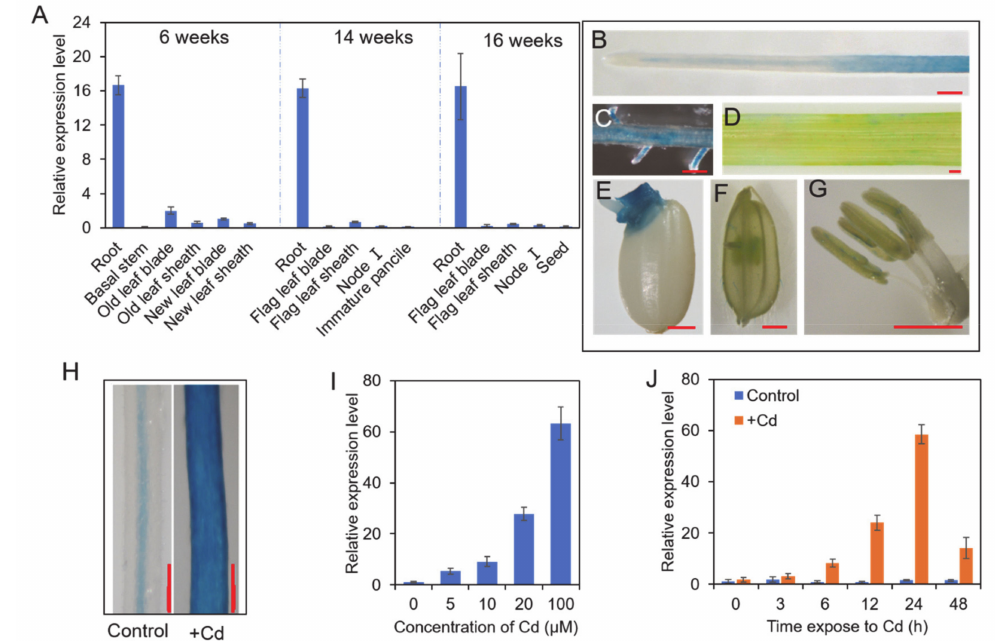
Figure 2. Expression pattern of OsNAC300 . ( A ) Relative expression of OsNAC300 in various tissues at different growth stages. Samples of various organs were taken from rice grown in a paddy field. ( B – H ) β -glucuronidase (GUS) staining, bar = 1 mm. ( B ) Region of primary roots (PR). ( C ) Region of lateral roots (LR). ( D ) Leaf. ( E ) Germinating seed. ( F ) Floret. ( G ) Stamen. ( H ) Region of PR under –Cd and +Cd (100 µ M) for 24 h. ( I ) Dose-dependent expression of OsNAC300 in the roots. Rice seedlings were exposed to a solution containing different concentrations of CdCl 2 for 24 h. ( J ) Time-dependent expression of OsNAC300 in the roots. Rice seedlings were exposed to a solution containing 100 µ M CdCl 2 for different times. The expression of OsNAC300 was determined by reverse transcription quantitative polymerase chain reaction (RT-qPCR). Actin was used as an internal standard. Expression relative to seedlings without addition of Cd is shown. Data are means ± SD of four biological